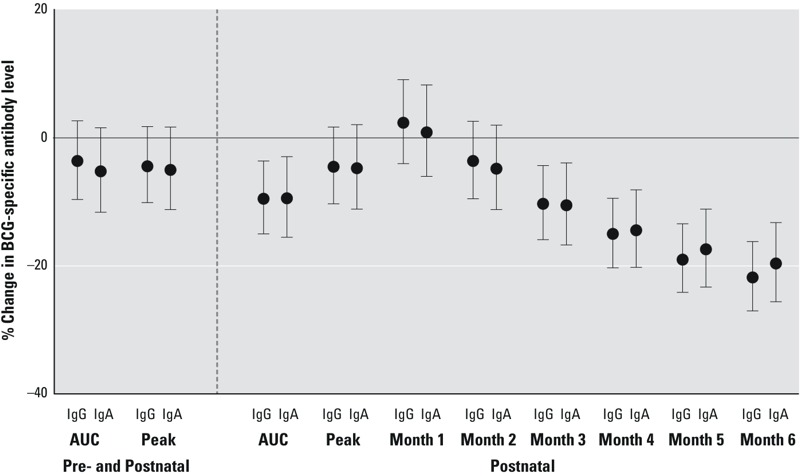
Estimated DDE concentrations from the physiologically based pharmacokinetic model (PBPK) and the percent change (95% CI) in 6-month BCG-specific IgG and IgA levels for an interquartile range difference in each DDE exposure. Pre- and postnatal models are adjusted for maternal ethnicity, education, age, smoking, and parity, and postnatal models are adjusted for maternal ethnicity, education, and age. Interquartile ranges as well as crude and adjusted numerical estimates are available in Table S3.